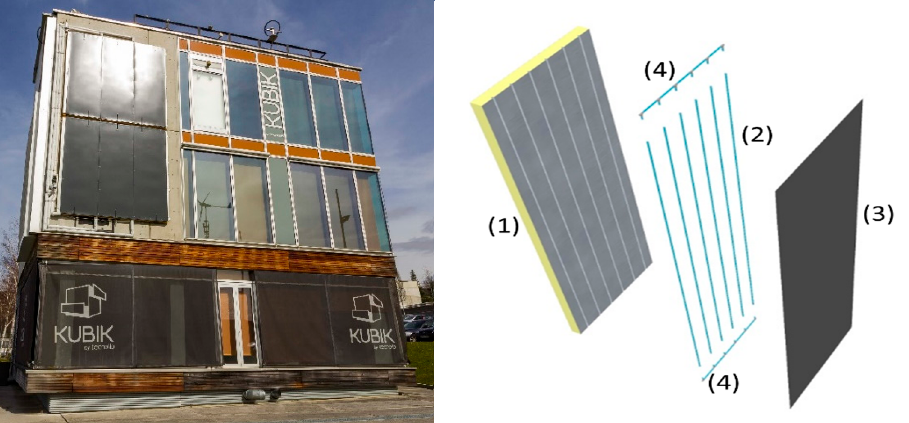
Figure 1. Unglazed solar collector installed on the building’s south oriented facade ( left ). Sandwich panel integrating the unglazed solar collector splitting the main components of the solution ( right ). Sandwich panel (1), nylon pipes (2), steel cover (3) and header elements (4).